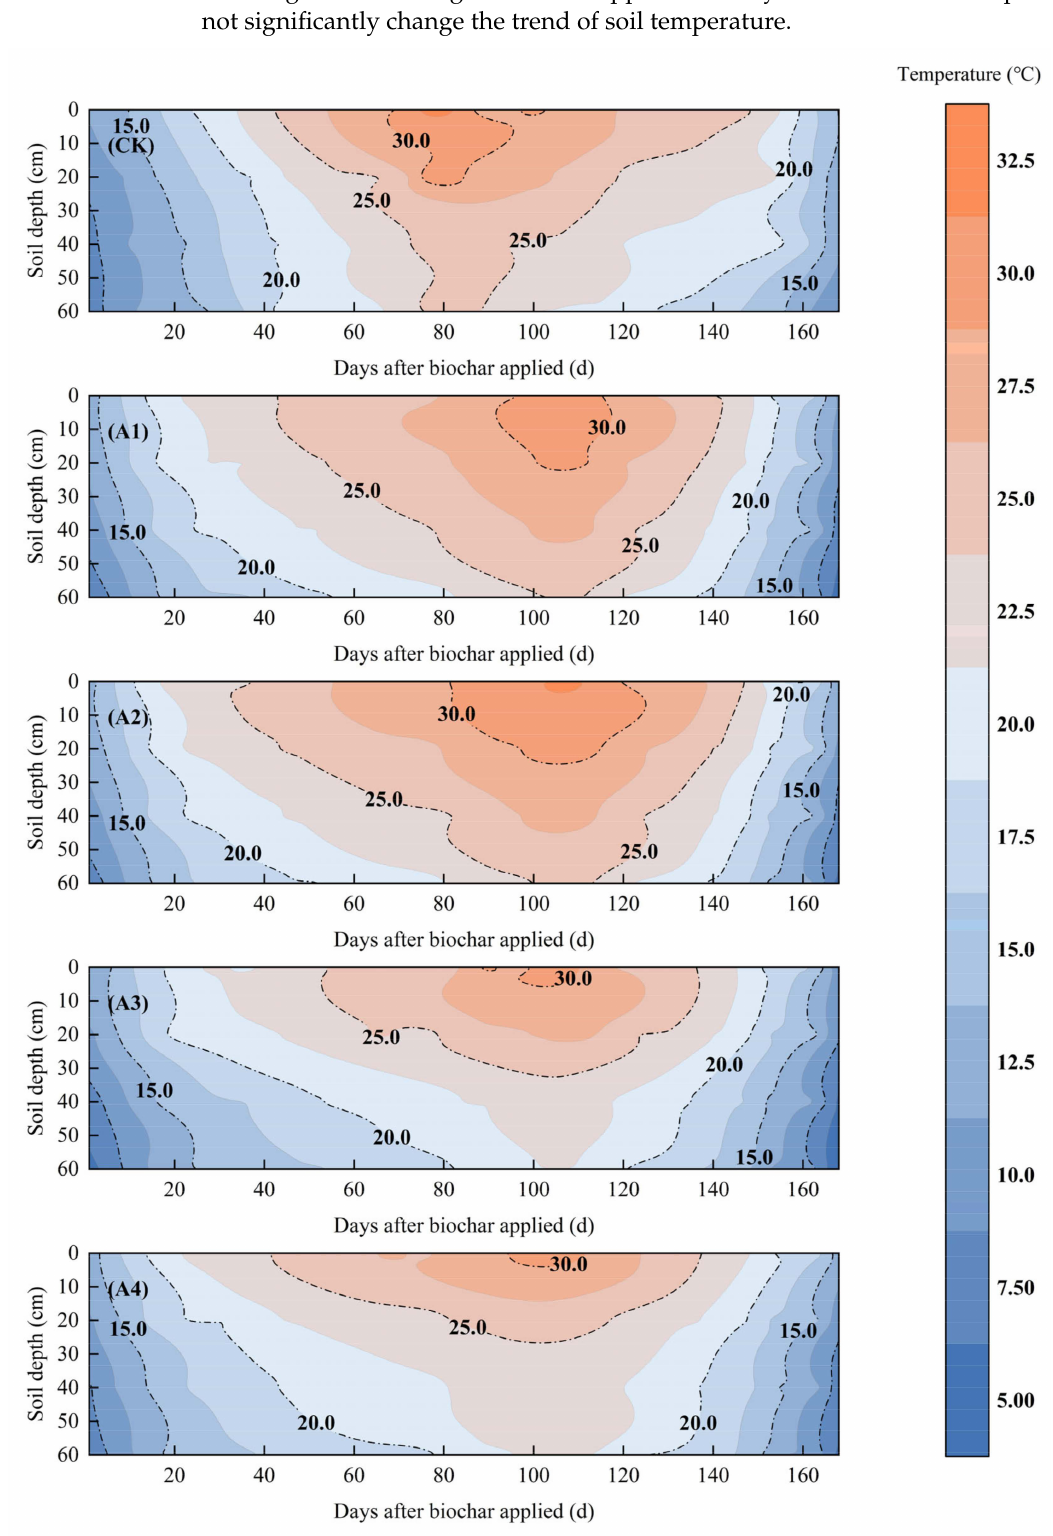
Figure 4. Soil temperature of treatments A and CK in 0–60 cm during the cotton growth